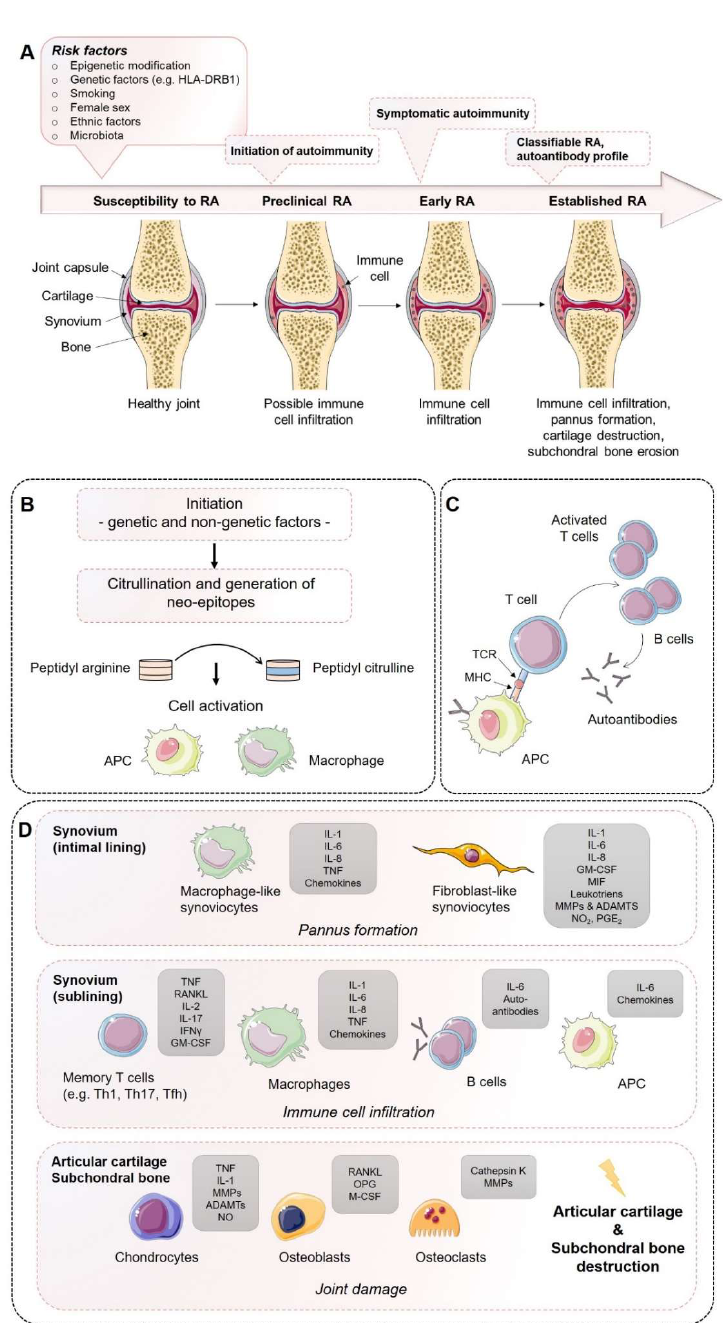
Figure 1. Establishment of rheumatoid arthritis (RA): Mechanisms of disease initiation, development, and progression. ( A ) Multiple risk factors, including both genetic and non-genetic influences, are required to induce the development of RA in susceptible individuals. Years before first clinical symptoms of RA occur, autoimmunity against modified self-proteins is initiated, which results in the onset of a subclinical inflamed synovium (symptomatic autoimmunity) propagated by immune cell infiltration and pannus formation. Once established, RA can be classified according to the clinical symptoms. ( B ) Onset of autoimmunity is supposed to occur in the mucosa (e.g., mouth, lung, and gut) by the creation of neo-epitopes as a result of post-translational modifications, e.g., by citrullination. These neo-epitopes